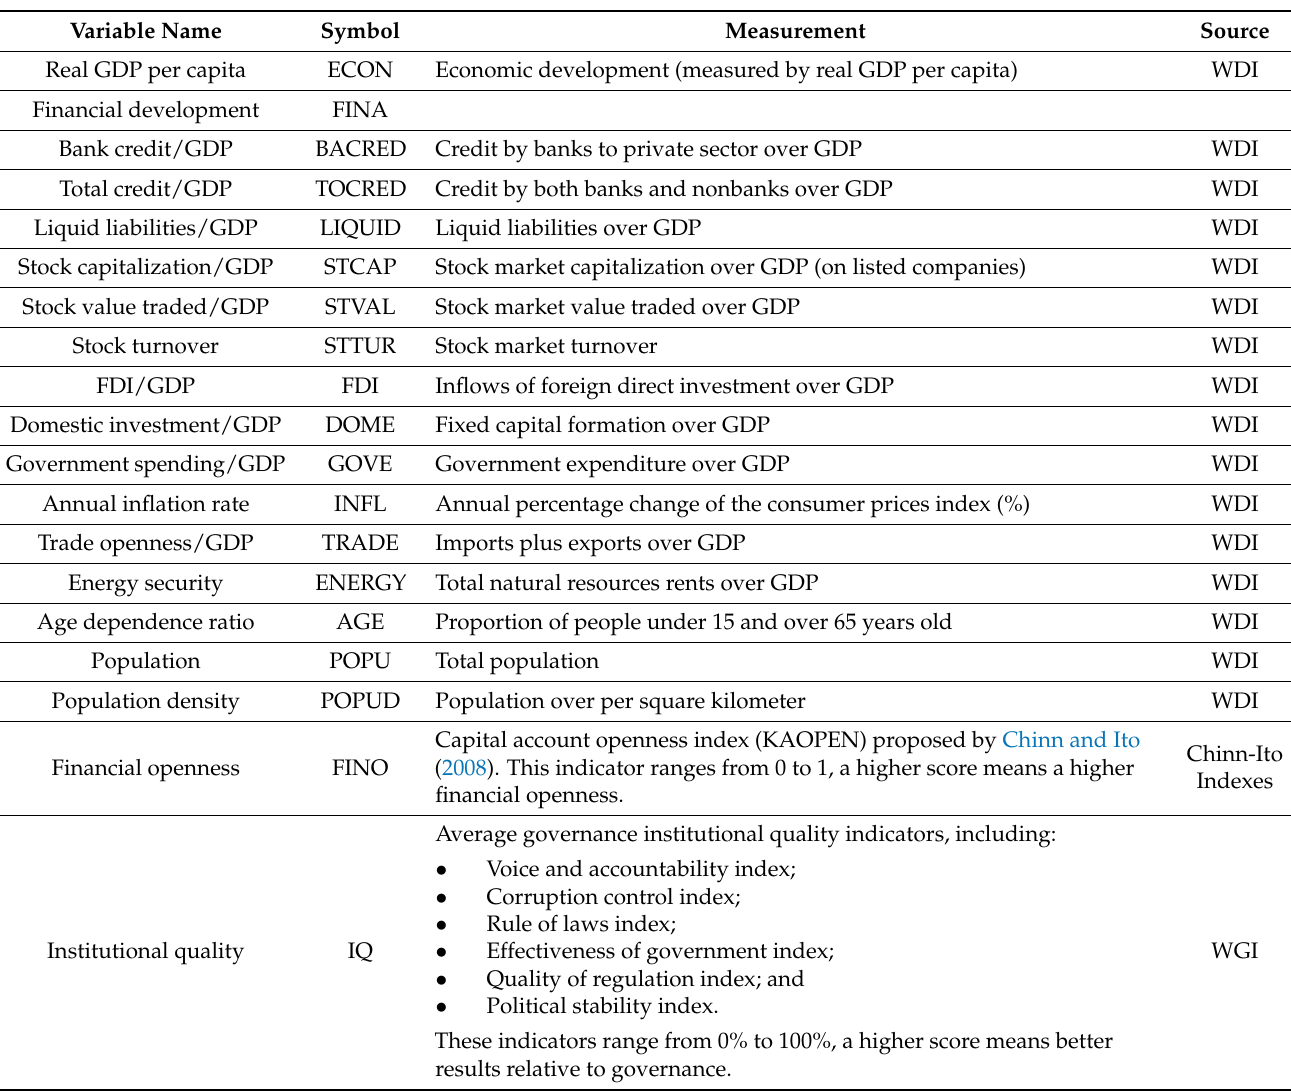
(2008) and institutional quality indexes from World Governance Indicators (WGI). Table 1 defines the model variables and their measurements. Table 1. Model variables definitions and